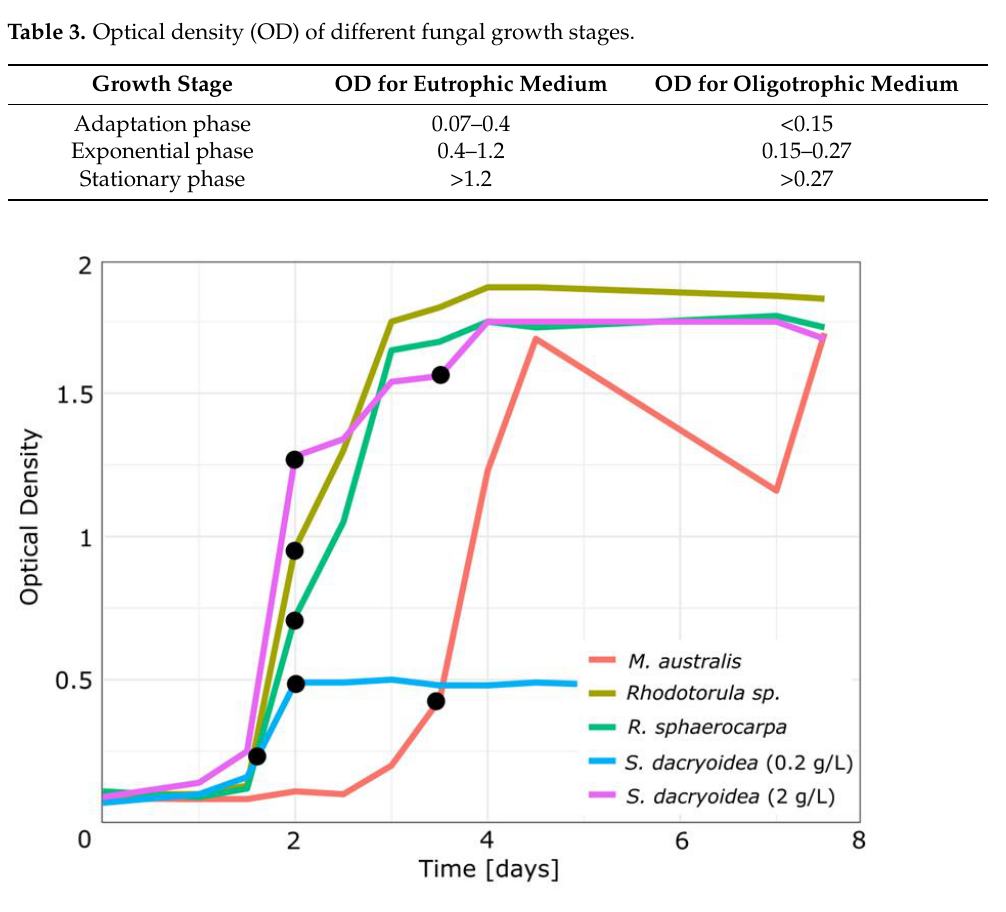
Figure 1. Growth of yeast cultures as indicated by optical density. Note: S. dacryoidea was cultured in two different nutrient concentrations (0.2 and 2 g/L glucose, blue and purple line, respectively). The other fungal species were grown with 2 g/L glucose. Black dots indicate the sampling times.